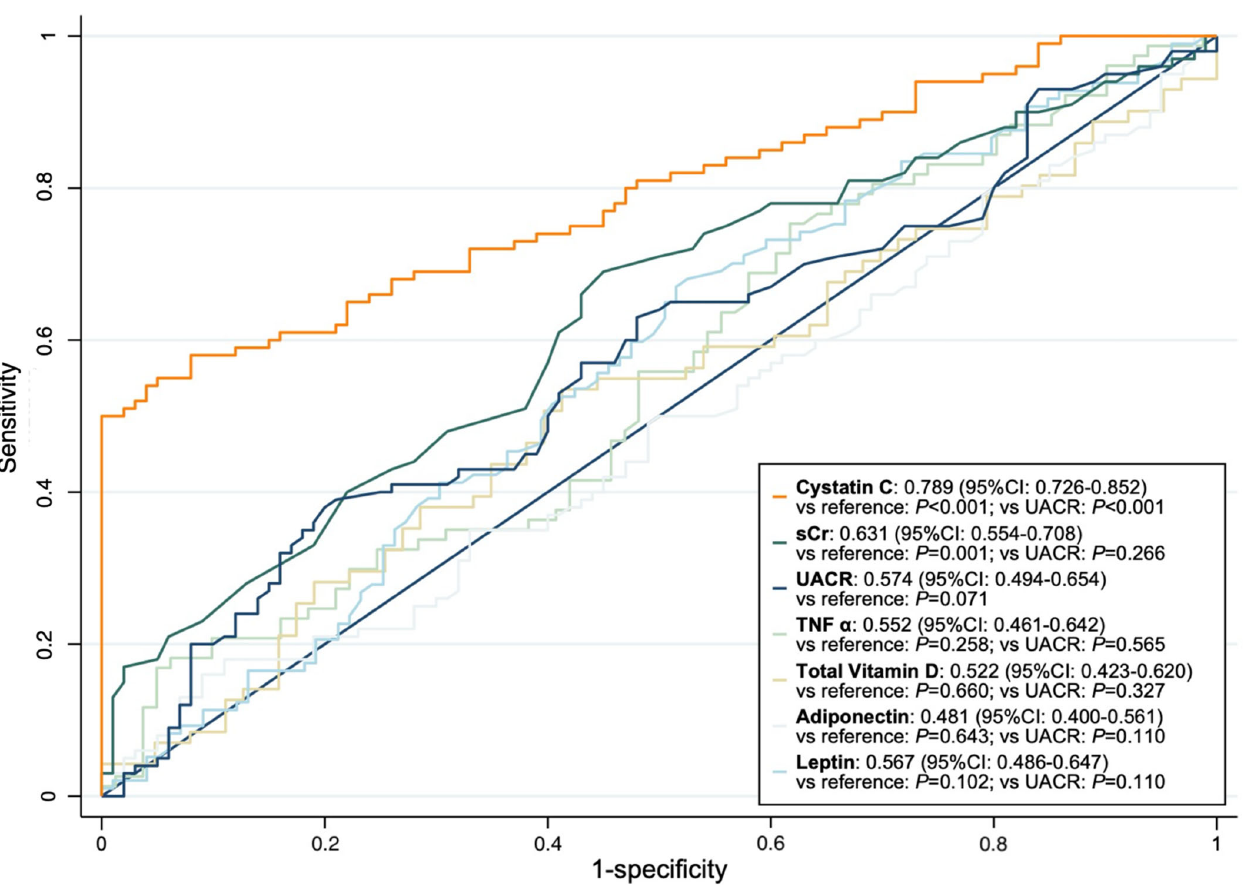
Figure 2. The area under the receiver operating characteristic curve of cystatin C, UACR, and sCr to predict the occurrence of 5-year RKFD. Abbreviations: RKFD, rapid kidney function decline; sCr, serum creatinine; TNF- α , tumor necrosis factor- α ; UACR, urine albumin-to-creatinine